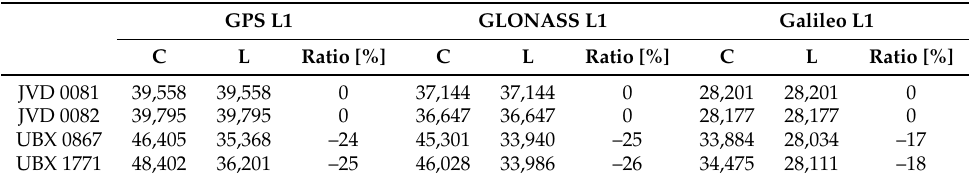
Table 5. Number of L1 code range (C) and carrier phase (L) observations of three satellite systems of two geodetic-grade receivers (JVD 0081 and 0082) and two high sensitivity receivers (UBX 0867 and 1771) during the test drive.